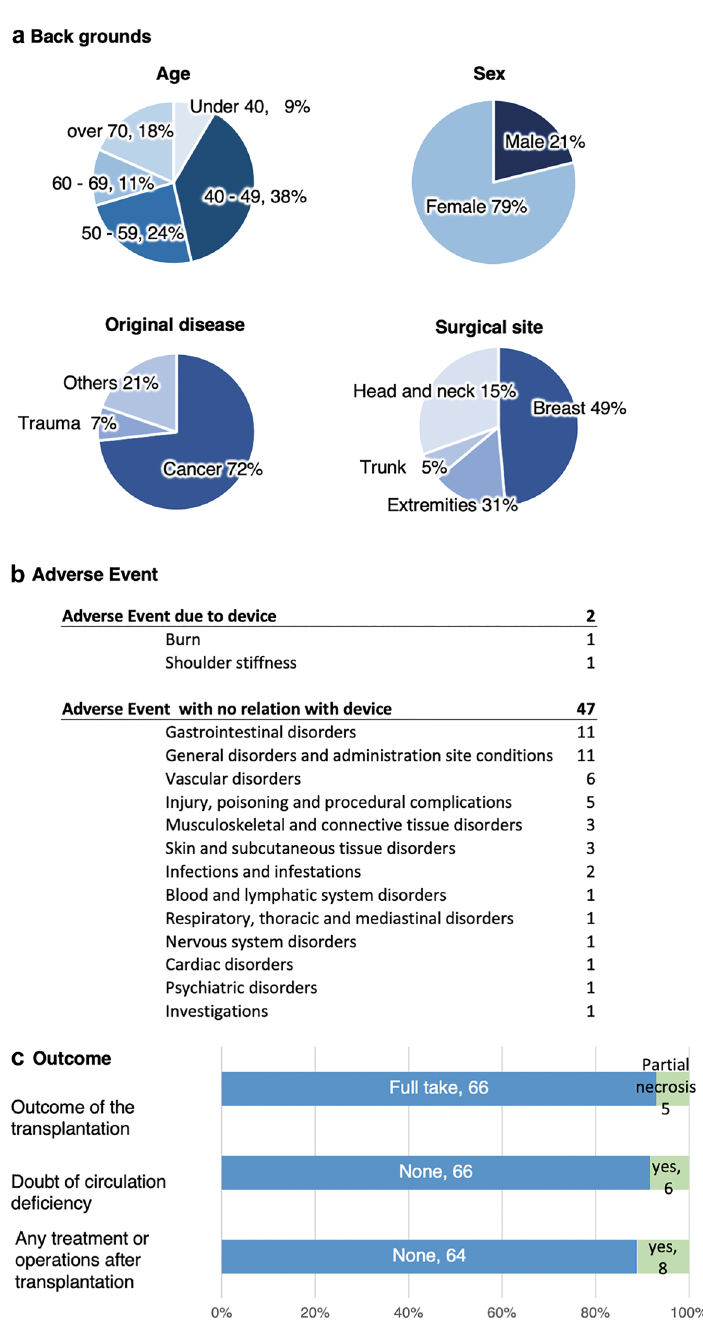
Figure 4. Overview of the clinical trial population—demographics and outcomes. ( a ) Breakdown of the trial population by several variables. The participants were 54.5 years of age on average, but all age categories were represented. Of these, 79% of the participants were female, reflecting the large number of breast reconstruction patients. The original disease was cancer in 73% of cases. Almost half of the surgical sites were breasts, followed by the extremities (31%), and head and neck (15%). ( b ) Summary of the adverse events experienced by patients. Unfortunately, our first case had a 1 cm × 1.5 cm burn due to insufficient waterproofing of the sensor system. After deep reflection, we improved the system by increasing the waterproofing of the sensor and implementing functions to prevent excessive current flow. One additional type of adverse event caused by the device was shoulder discomfort from prolonged wear in all cases. ( c ) Summary of tissue transplantation clinical outcomes. There was no total necrosis, partial necrosis in 7.6% of cases, and full survival of the transplant tissue in the remaining 92.4% of